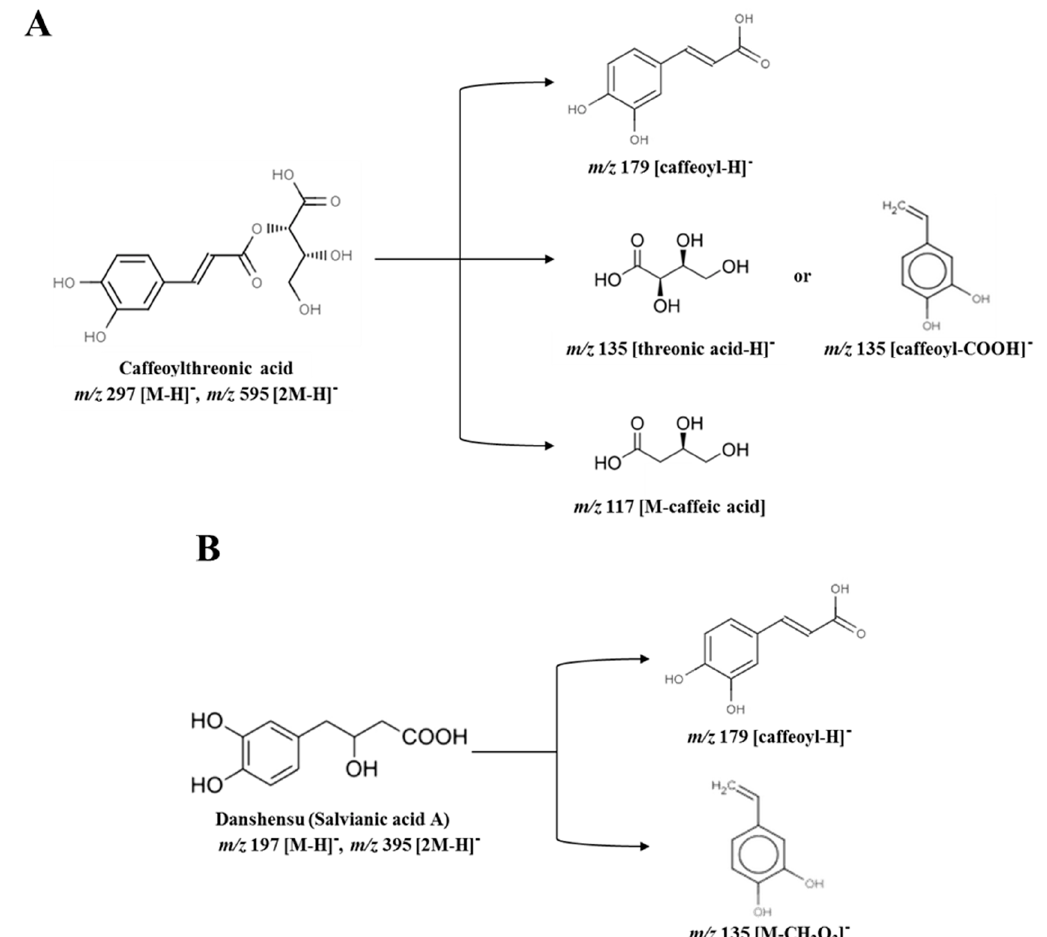
Figure 4. Fragmentary patterns of ( A ) caffeoylthreonic acid and ( B ) danshensu in sub-fraction 1-3 obtained from the 75% ethanol extract of Actinidia arguta leaves.